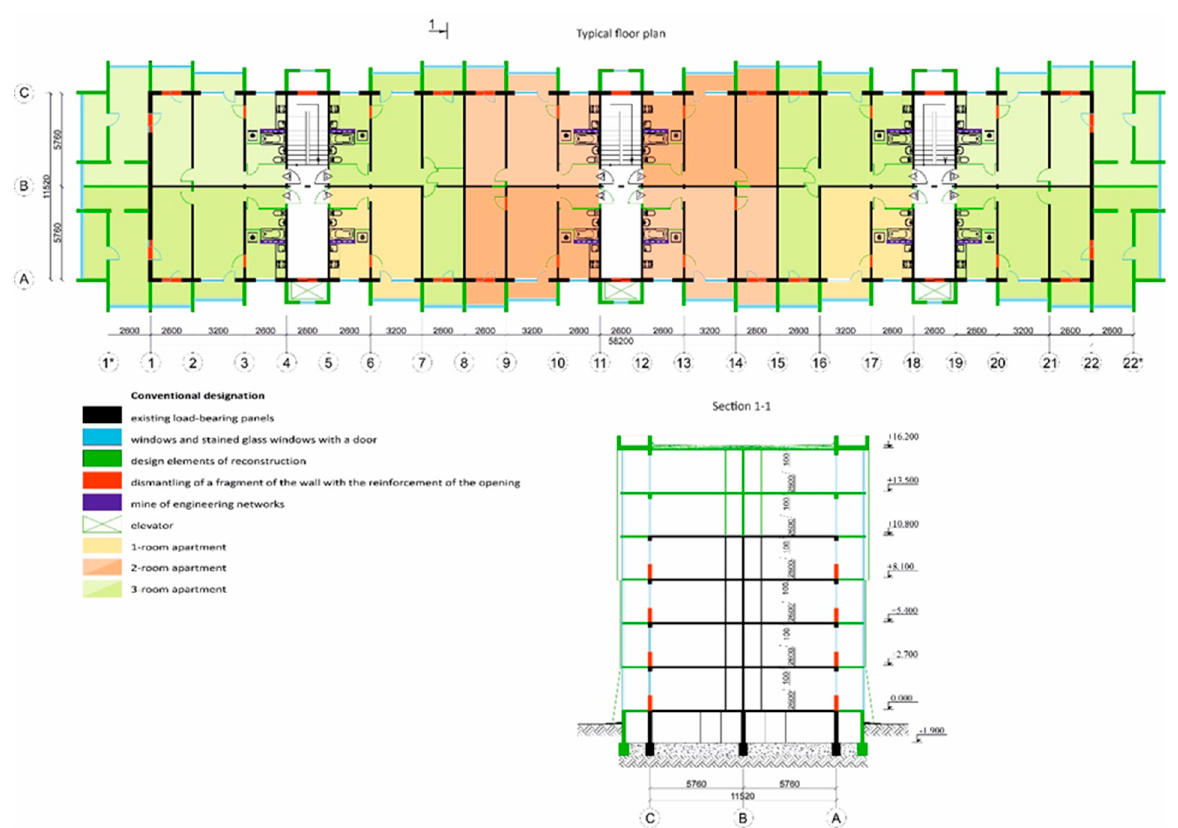
Figure 19. Proposal for the redevelopment of a residential building with an attic floor superstructure (Author’s material).